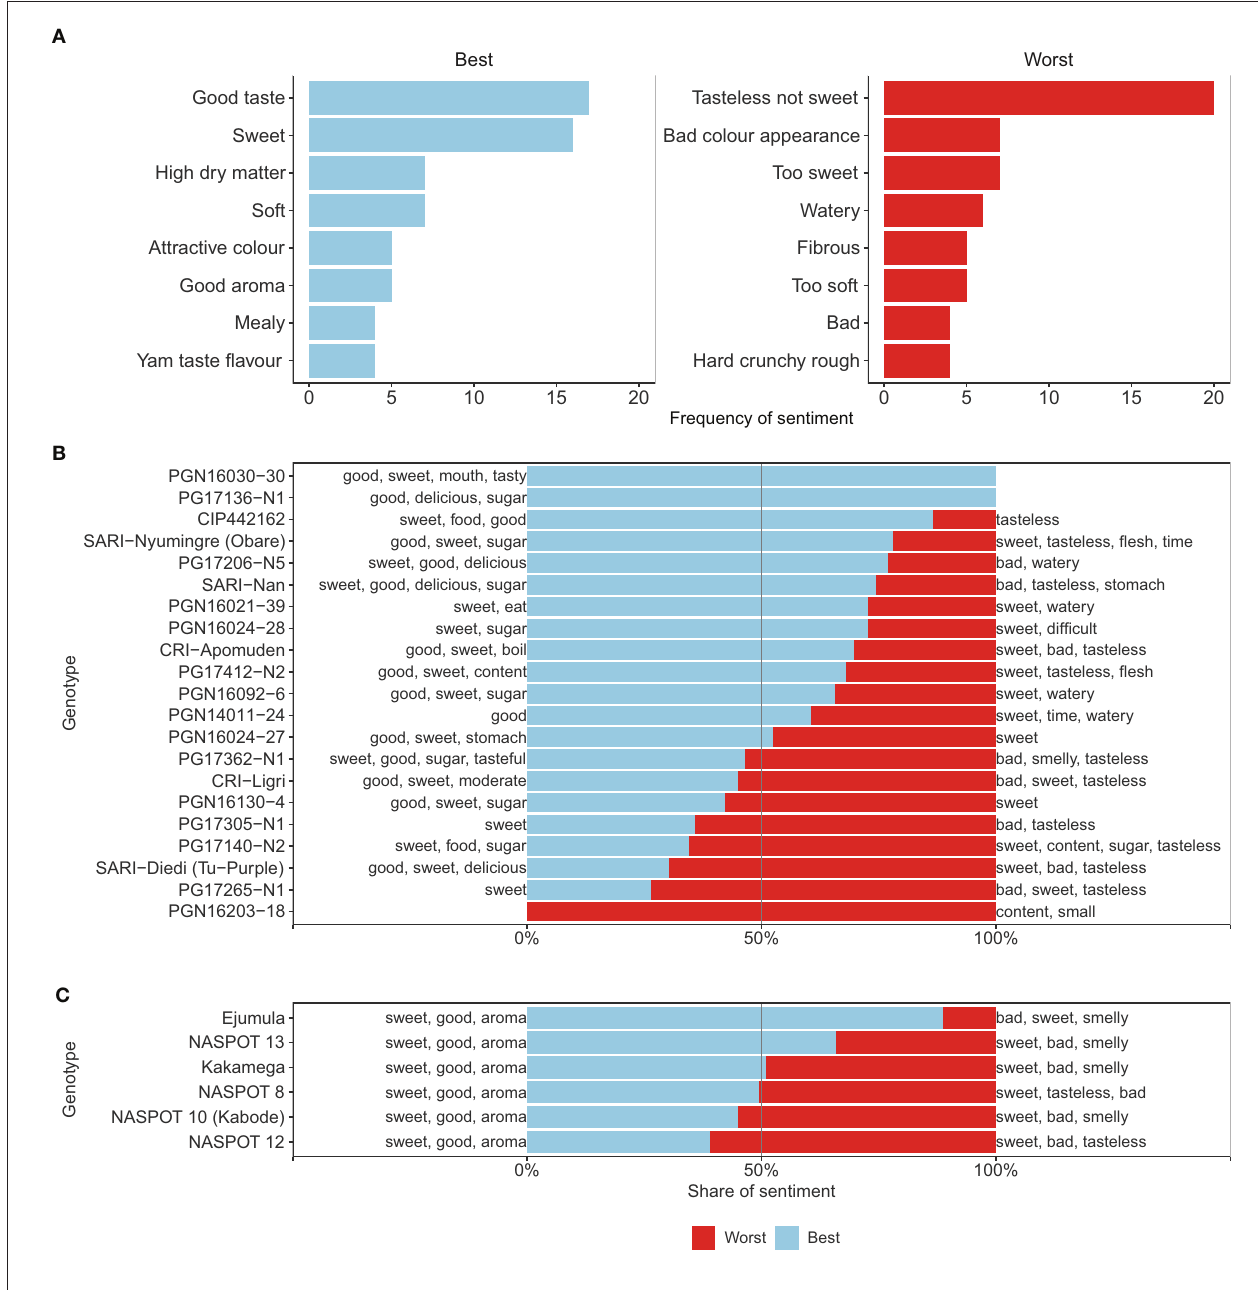
FIGURE 6 | Sentiment analysis for the drivers of consumer preference for boiled sweetpotato genotypes. (A) Overview of the drivers of best and worst appreciation of boiled sweetpotato genotypes in Ghana and Uganda. (B) Share of sentiment for the evaluation of a given genotype as best or worst in Ghana. (C) Share of sentiment for the evaluation of a given genotype as best or worst in Uganda. Sentiments on the left side are the most common words associated with a given genotype for best preference. Sentiments in the right are the most common words associated with a given genotype for worst